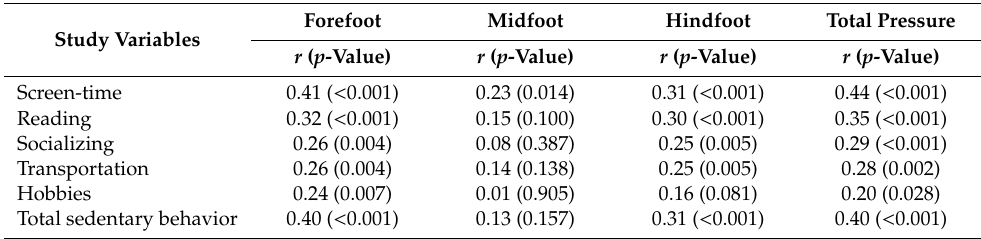
Table 2. Unadjusted correlations between sedentary behavior domains and total sedentary behavior with peak plantar pressures ( n =